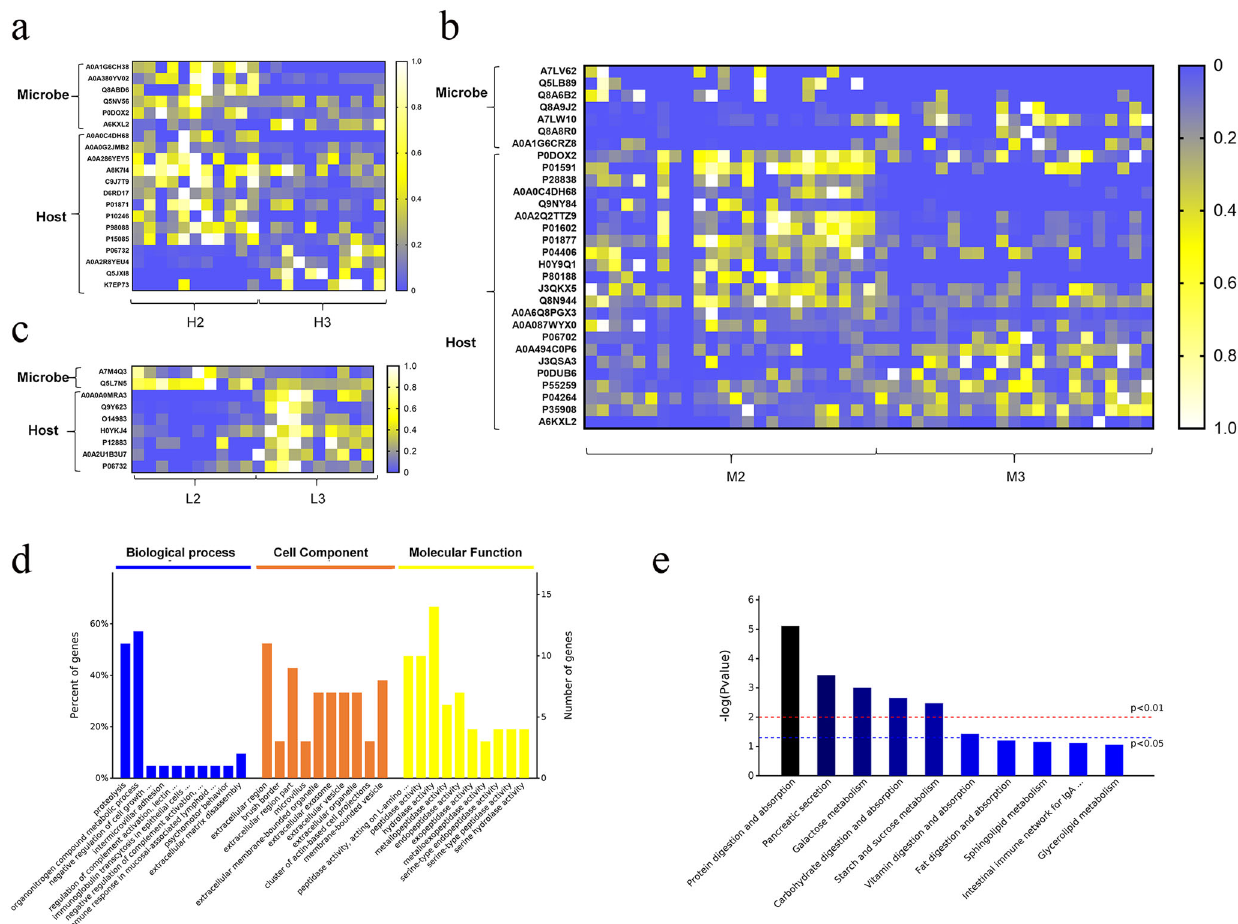
Fig. 5 Differential fecal proteome pro fi ling induced by diet alteration. a – c Heatmaps of metabolites from the high- ( a ), middle- ( b ) and low- BMI volunteers ( c ); d , e Functional annotation using GO ( d ) and KEGG orthology group assignments ( e ). The color bars in ( a – c ) indicate the relative abundance of identi fi ed